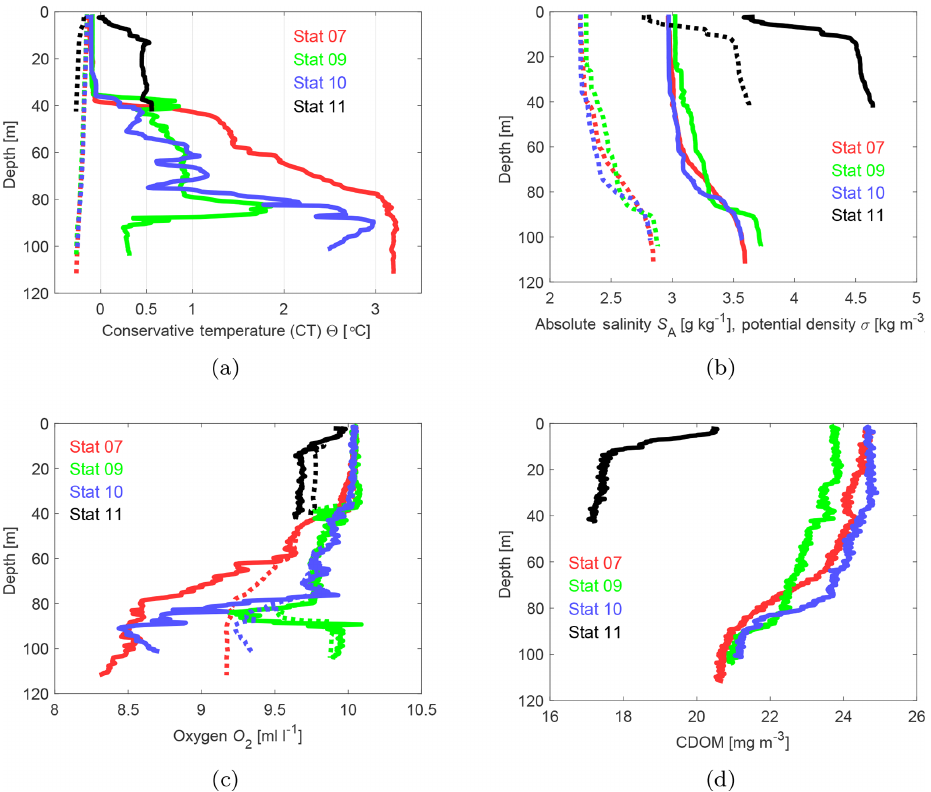
Figure 7. Shipborne CTD profiles at stations 7, 9, 10, and 11 (Fig. 3) for conservative temperature (a) , absolute salinity (b) , oxygen (c) , and CDOM (d) . Dotted lines show the freezing temperature (a) , the potential density (b) , and the saturation oxygen concentration (c)